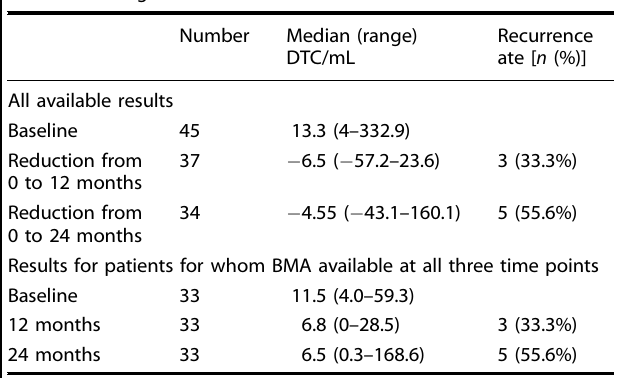
Table 2. Change in DTCs over time.